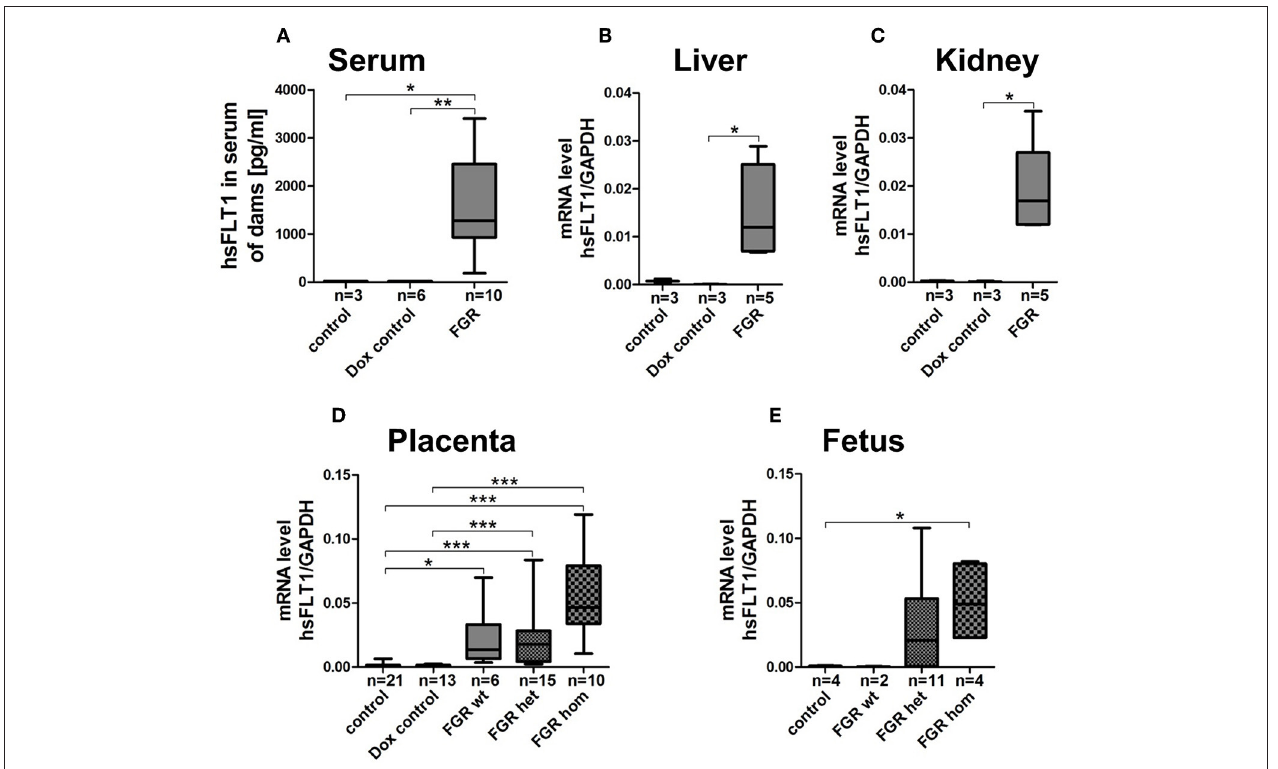
FIGURE 2 | Expression level of hsFLT1 protein in maternal blood serum as measured by ELISA (A) and expression of hsFLT1 mRNA in maternal liver (B) and kidney (C) as well as in placentas (D) and fetuses (E) as determined by qPCR of the hsFLT1/rtTA mouse model. Expression of human soluble fms-like tyrosine kinase 1 (hsFLT1) occurred only in the mice that exhibited induced hsFLT1/rtTA (reverse tetracycline-controlled transactivator) after treatment with doxycycline ( + Dox) (FGR group) and that also exhibited higher placental and fetal hsFLT1 expression depending on the fetal rtTA genotype. Low hsFLT1 expression was detectable in FGR wild-type (wt) placentas and no hsFLT1 expression in FGR wt fetuses or in the control and Dox control groups. Samples were obtained from complete placentas and fetuses and from maternal livers and kidneys at day 18.5 post coitum (dpc). Measured mRNA levels were normalized to Gapdh . * p < 0.05, ** p < 0.01 and *** p < 0.001, as determined by the Kruskal–Wallis test and Dunn’s post hoc